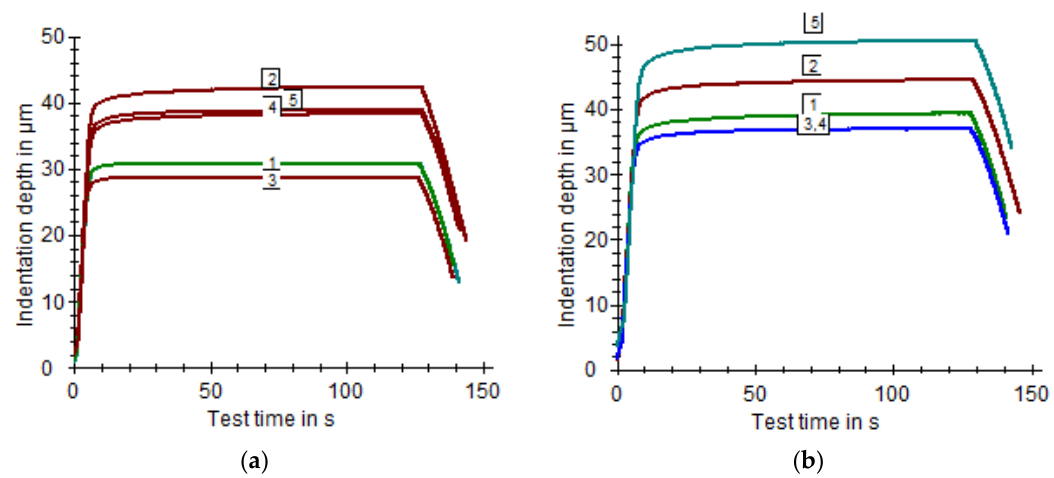
Figure 3. Indentation depth-time IIT curves for the dual-cured ( a ) and self-cured ( b ) products tested based on the tetragonal pulse loading (Figure 1). All the products, exempt for SPC, demonstrated lower curve profiles in dual- than light-curing modes.1: PSP, 2: PSU, 3: PV5, 4: SPC, 5: THC. Table 3. The results of C IT for the products tested in dual-curing (DC) and self - curing (SC) modes *. Product C IT (%)